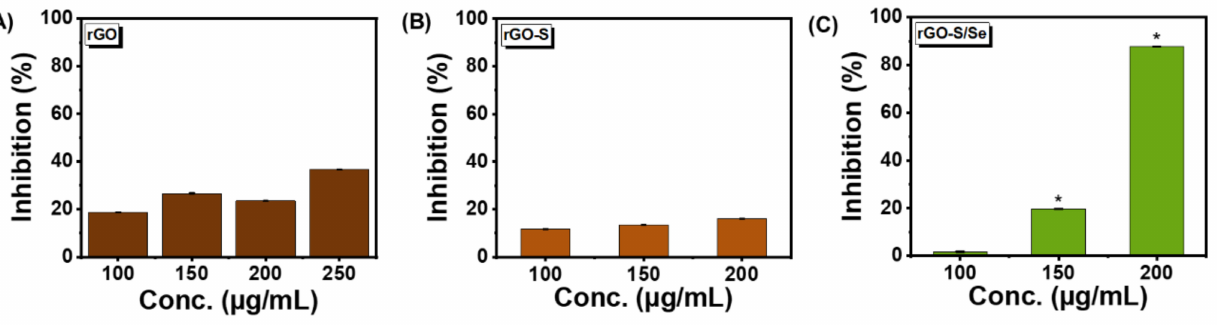
Figure 6. Effect of rGO, rGO-S, and rGO-S/Se on E. faecalis growth. Percentage of bacterial growth inhibition when exposed to varying concentrations of ( A ) rGO, ( B ) rGO-S, and ( C ) rGO-S/Se; * p -value < 0.01. Error bar represents the standard error of the